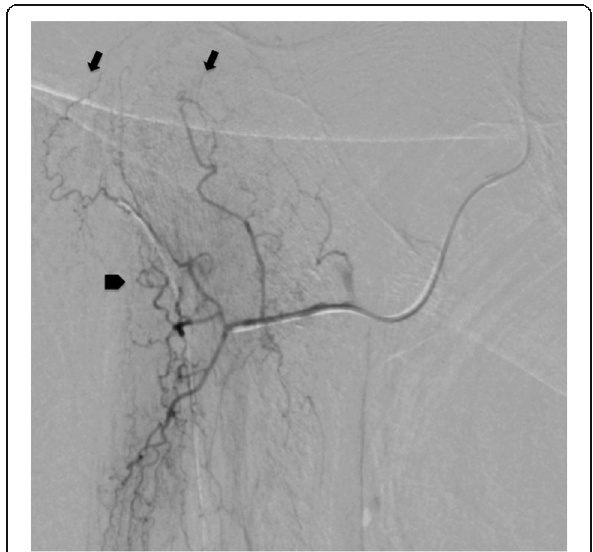
Fig. 2 Super selective angiography of the ascending branch of the lateral femoral circumflex artery with a 2.4Fr micro catheter. The “ inflammatory blush ” was not found, however, small corkscrew arteries ascending to he point of hipersignal in the CT were found (arrows). There were a few more corkscrew-shaped arteries in a point of pain during the procedure (arrowhead), which were also occluded